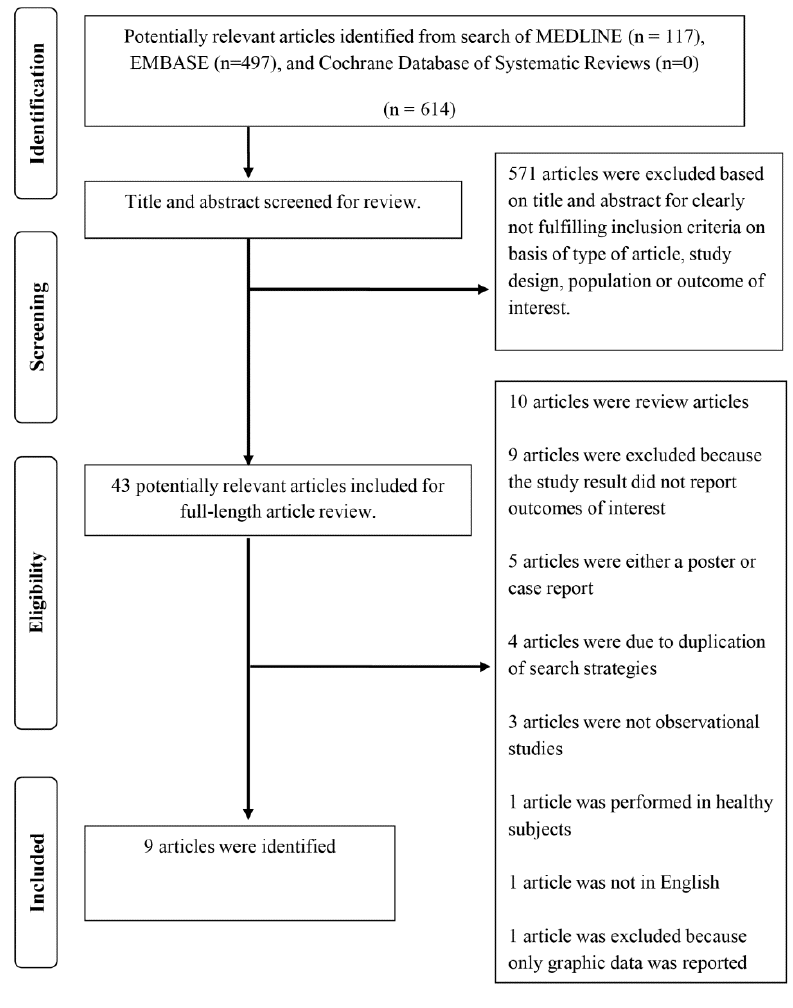
Figure 1. Outline of our search methodology.